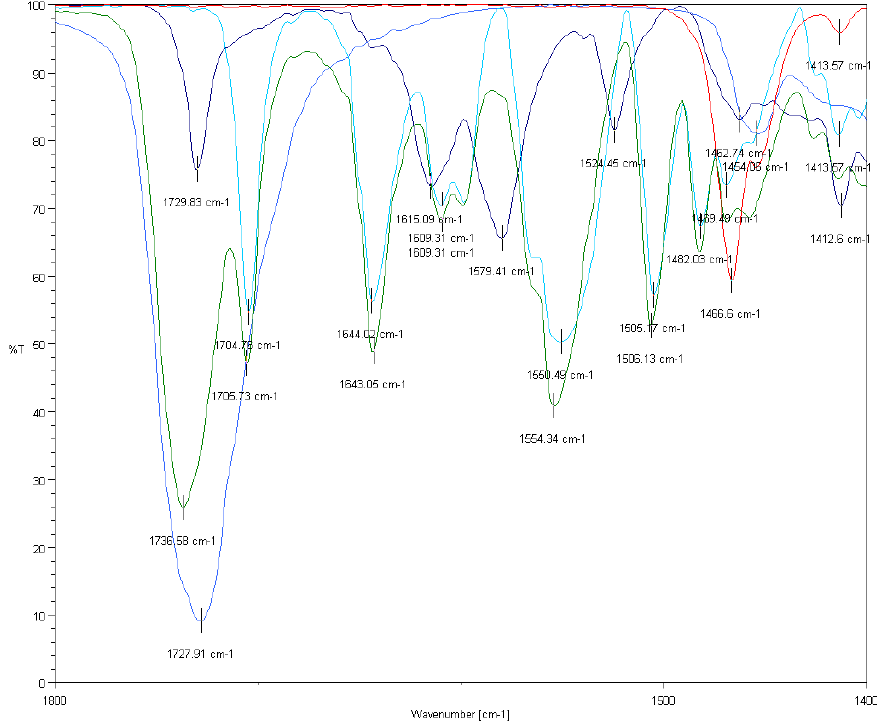
Figure 4. FTIR spectra of doxorubicin HCl salt (dark blue), sorafenib (light blue), PHB polymer (blue), amino-PEG (red) and dual drug-loaded PEGylated PHB nanoparticles (green) in the 1400–1800 wavenumber region.